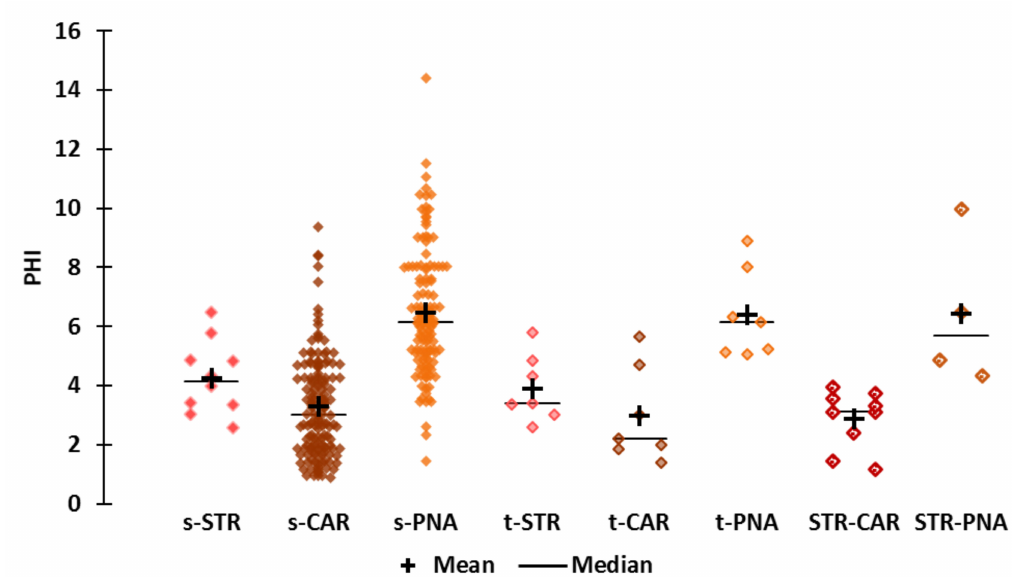
Figure 5. Scattergrams of the PHI values by odor